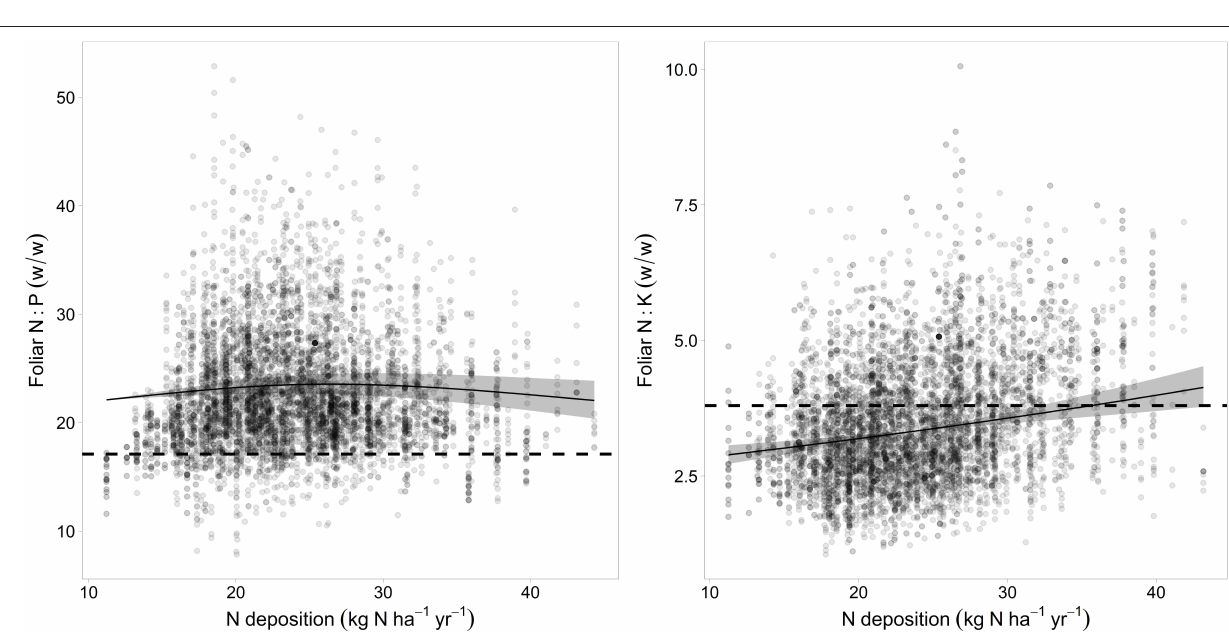
ratios. While climate explains neither a trend nor a significant part of the variation of Ca concentrations (left part), it explains 57% of the observed negative time trend of N:K (right